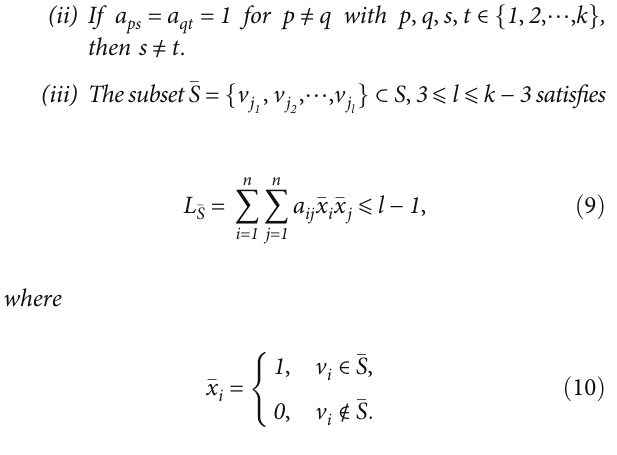
Figure 3: A directed graph with vertices of type I and type